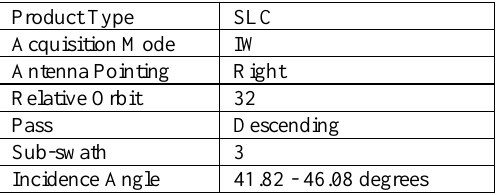
Table 1. Properties of the SAR images used in the